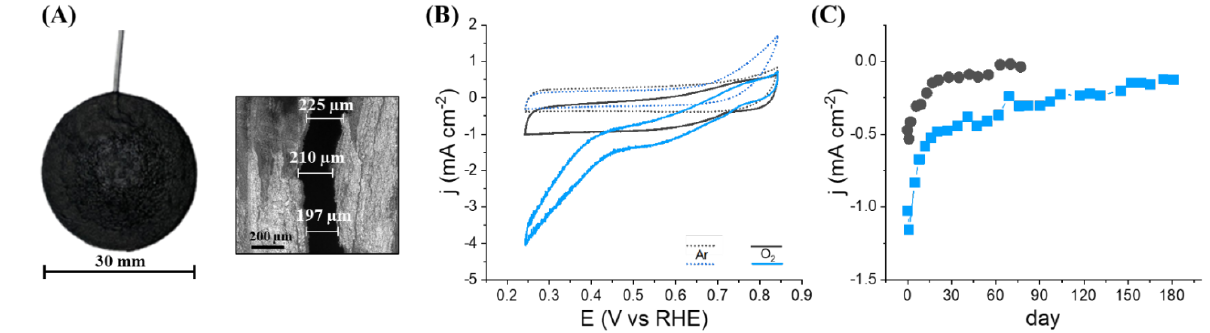
Figure 1. ( A ) Face view photography of the hollow MWCNT-based buckypaper electrode and laser intensity image of vertical cross section of a hollow electrode. ( B ) Cyclic voltammograms recorded in phosphate buffer (pH 6.5; 1 mV s −1 ) at hollow electrodes based on L bp (black) or hemin-L bp (blue) glued with C bp and containing BOx (2.0 mg) trapped inside the electrode cavity. Buffer under argon (dashes) or O 2 (solid lines). ( C ) Evolution of the faradic catalytic current at 0.5V for the reduction of O 2 as a function of time recorded periodically on hollow electrodes based on L bp (black) or hemin-L bp (blue) and containing 2 mg of BOx. Both bioelectrodes are stored in 0.1 M phosphate buffer (pH 6.5).